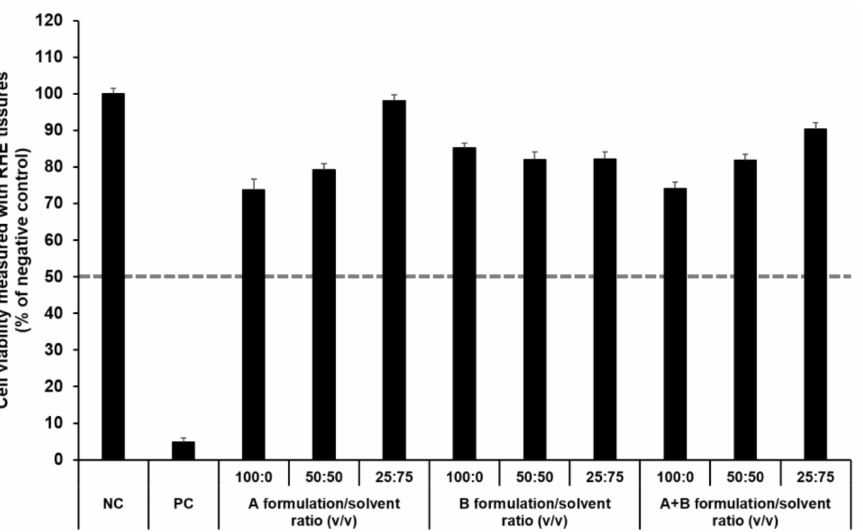
Figure 11. Viability of SkinEthic RHE tissue treated with components of the elastic artificial skin. The cell viability was measured using MTT assay. The values greater than 50% (dotted line) indicate that test materials are non-irritant to the skin. Results are expressed as means ± standard deviations of three independent experiments ( n =